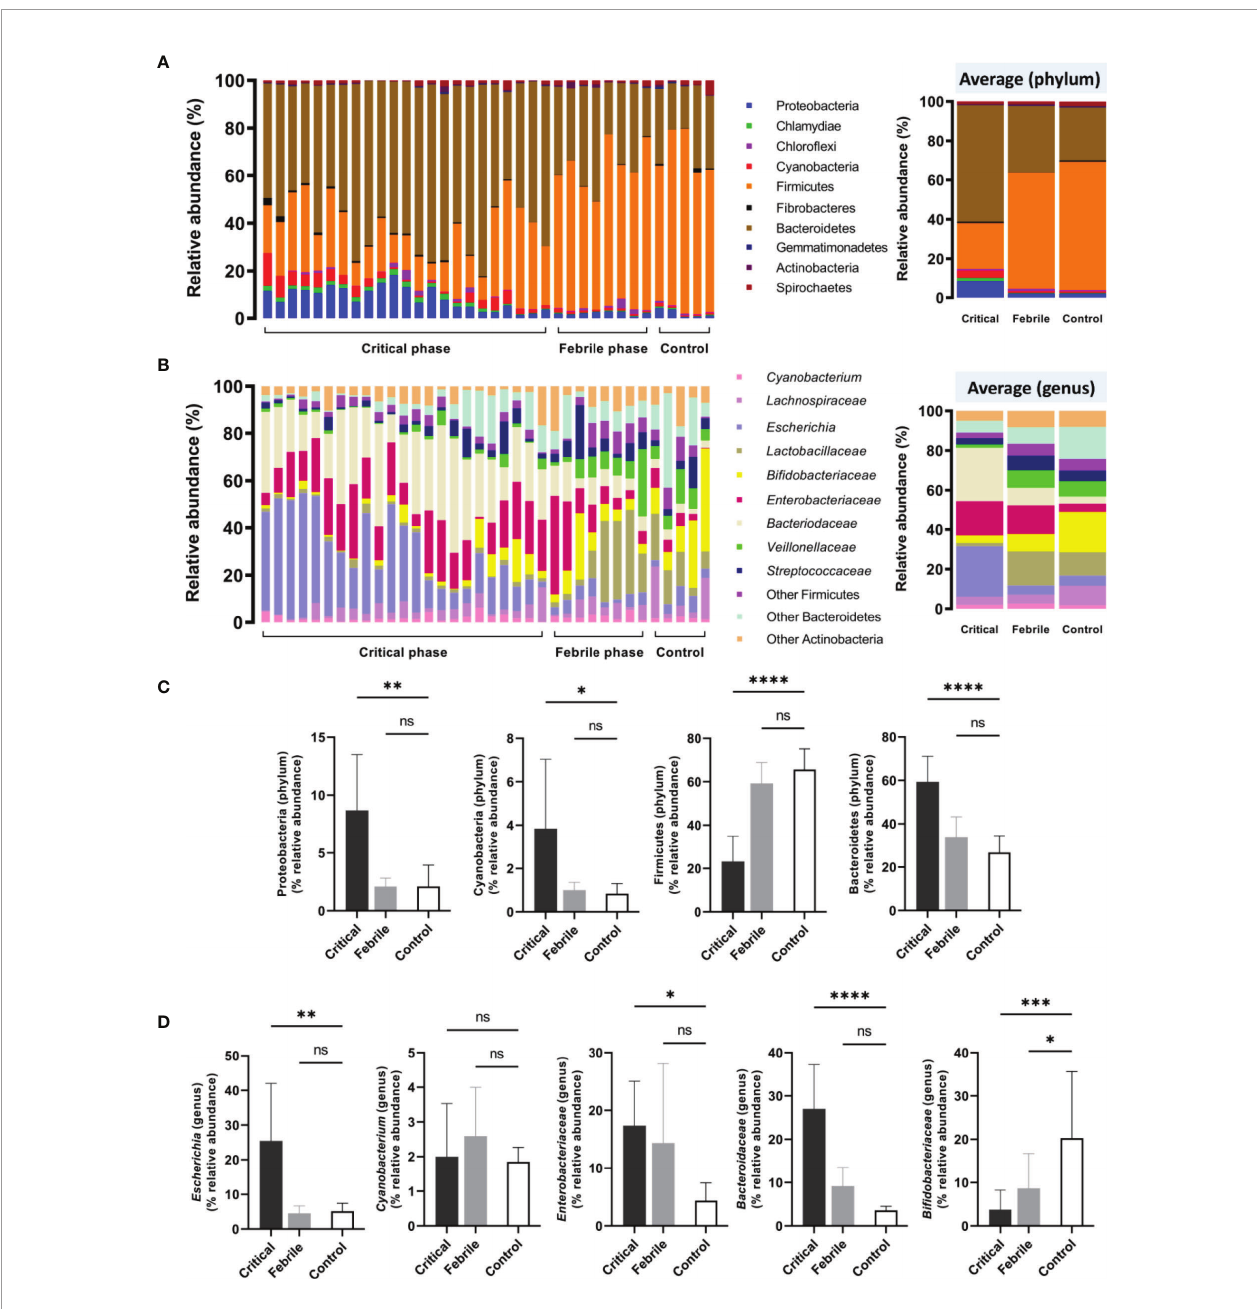
FIGURE 2 | Blood microbiome analysis (blood bacteriome) from samples of dengue patients in critical phase (Critical, n = 23), febrile phase (Febrile, n = 8), and healthy controls (Control, n = 5) as indicated by (A) the phylum-level analysis (with average values), (B) genus-level analysis (with average values, and selected phylum (C) and genus (D) analysis are demonstrated. * p < 0.05; ** p < 0.005; *** p < 0.0005; **** p < 0.0001; and ns, non-signi fi cant between the indicated groups using one-way ANOVA with Tukey ’ s